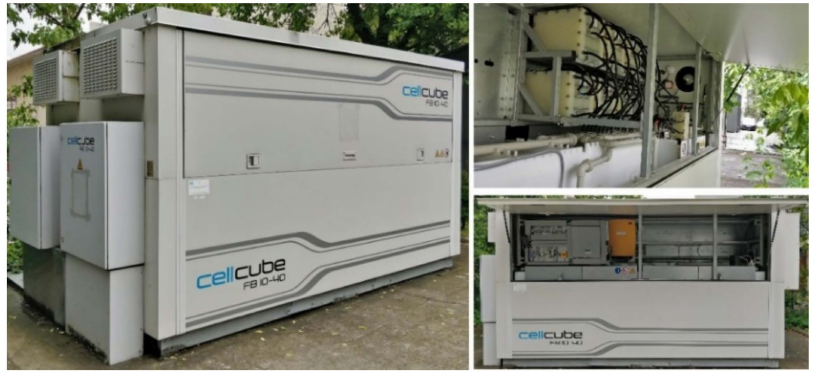
Figure 4. The storage unit attached to the PV system at the National Institute for Research and Development of Isotopic and Molecular Technologies, CETATEA building, Cluj-Napoca, Romania. The batteries and the associated control panels are presented in Figure 5.